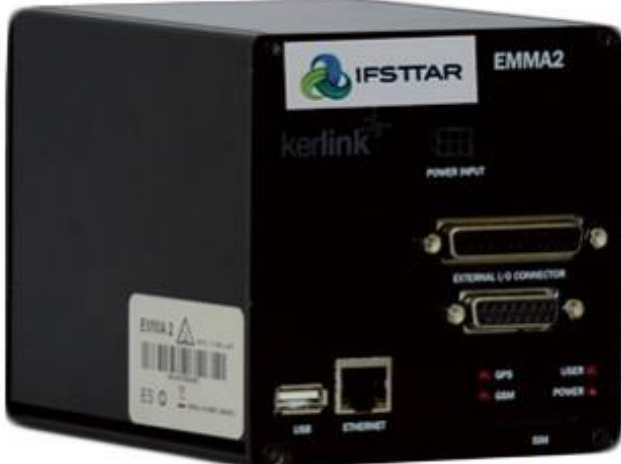
Figure 1. EMMA2 recording device.